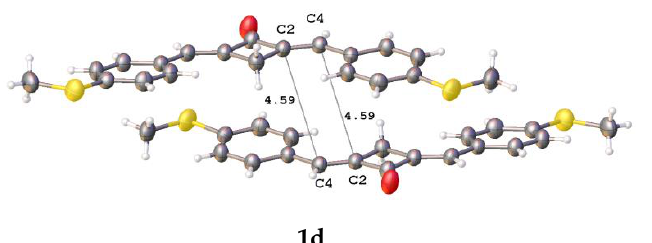
Figure 5. Fragments of crystal packings involving two adjacent molecules with close intermolecular ethylene-ethylene contacts in crystals of 1b – d ; the distances are given in Å. The distance between the ethylenic bonds in 1c is longer than 5 Å. In all the cases,